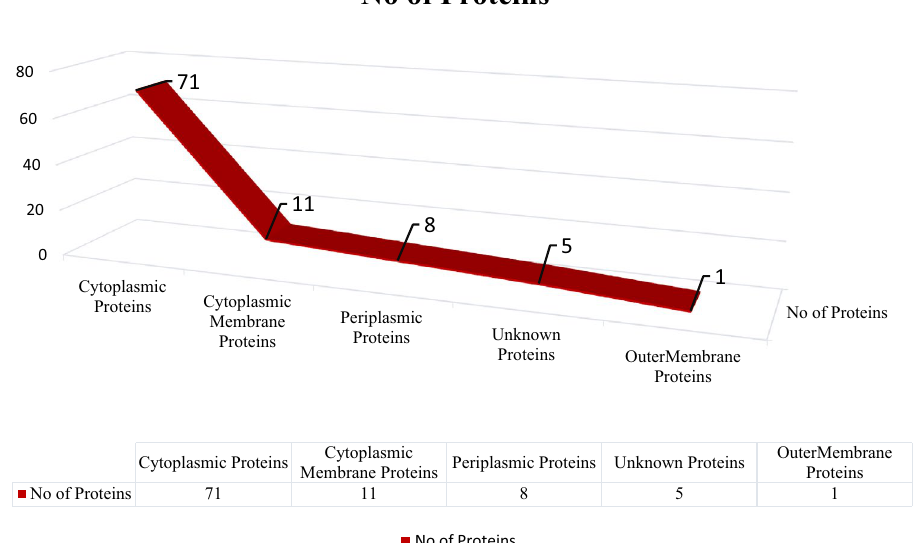
Figure 2. Sub-cellular Localization. Quantitative representation of sub-cellular localization of shortlisted essential, druggable, pathogen specific proteins predicted through